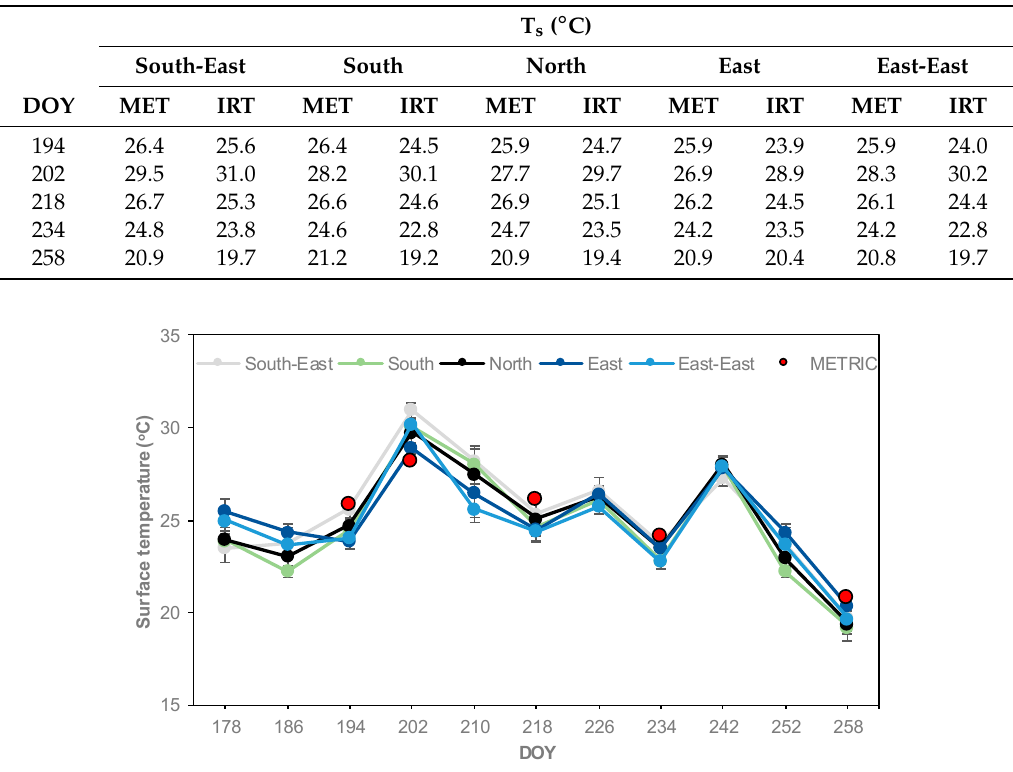
Figure 10. Seasonal comparison of instantaneous surface temperature (Ts) calculated with the METRIC model—red circles (values at the time of satellite overpass date for corresponding location)—and measured in situ with infrared thermometer (ten readings average in each location). Vertical bars represent standard deviations of Ts values measured with infrared thermometer.